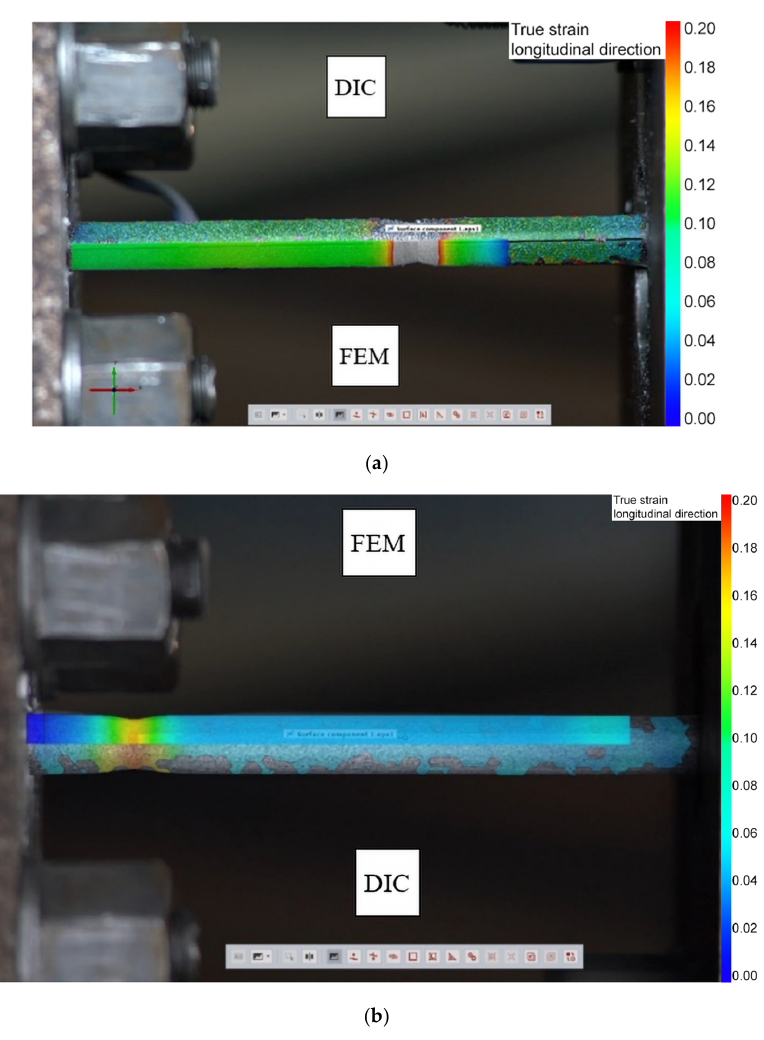
Figure 19. Comparison plots for true strain and normalized gauge length of tensile specimens between data points obtained from DIC analysis and FE simulation for ( a ) 0.001 s − 1 and ( b ) 0.5 s − 1 strain rates.